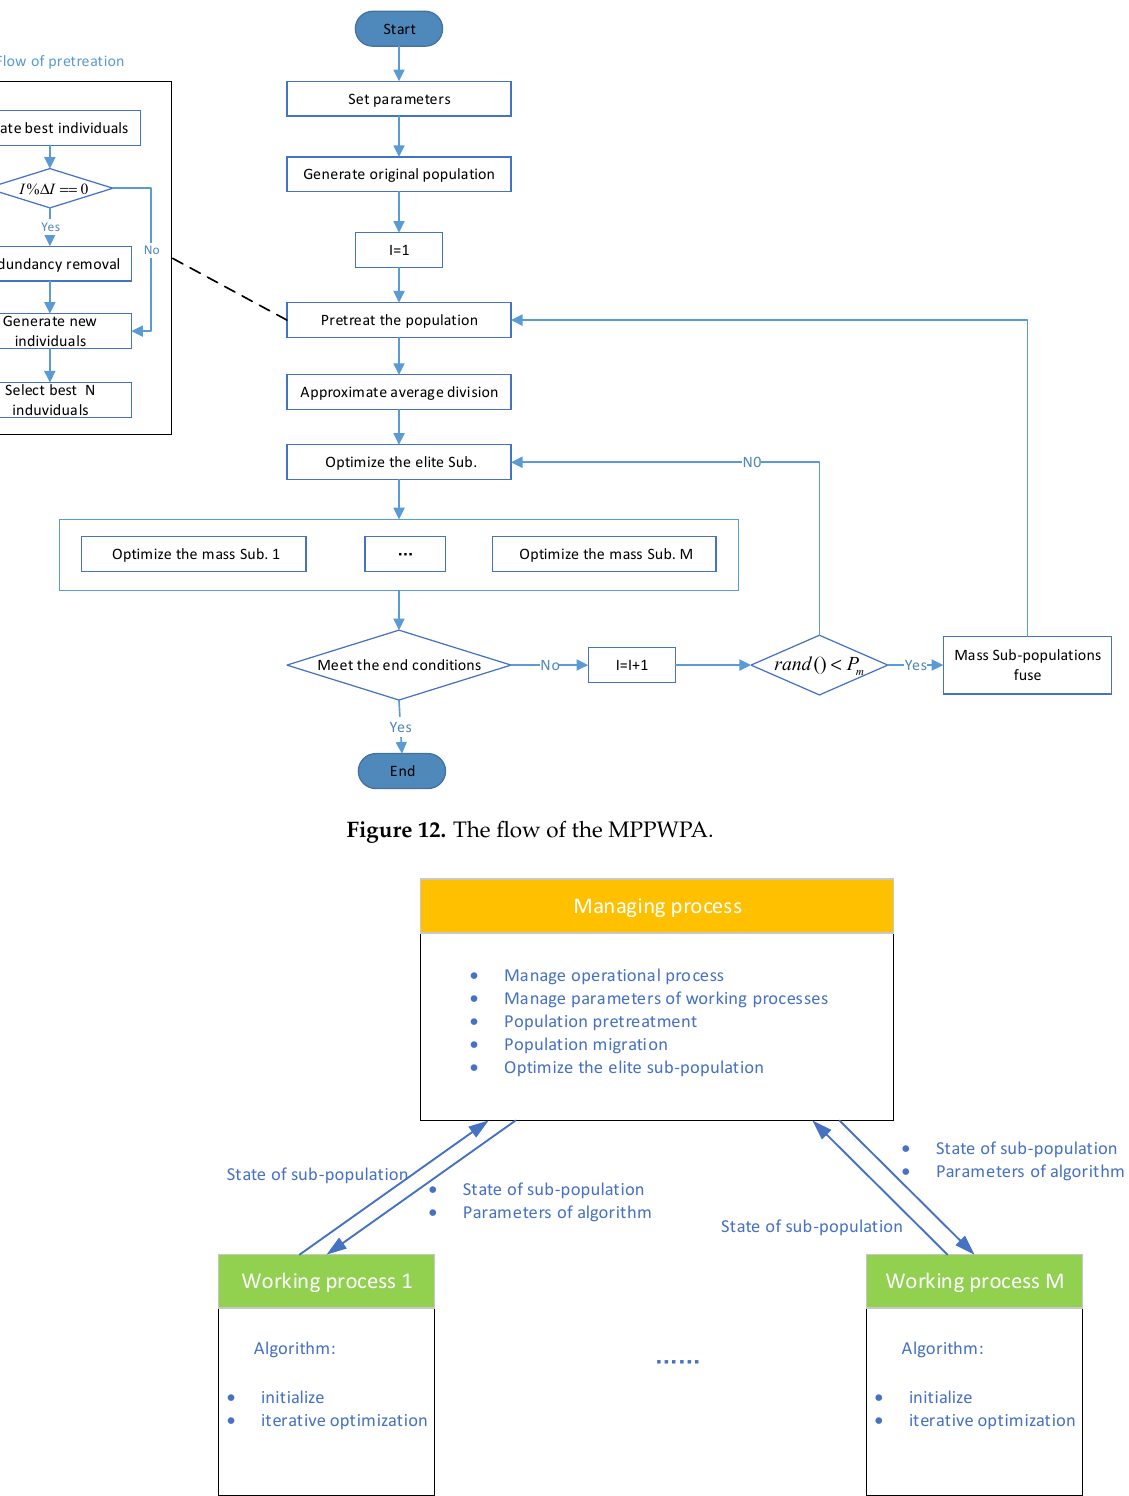
Figure 13. System for MPPWPA.